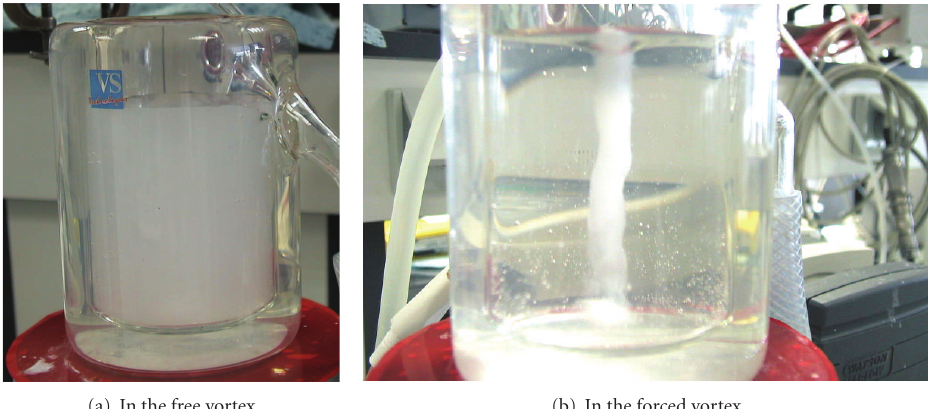
Figure 4: Reagent feeding position influence during the precipitation process.